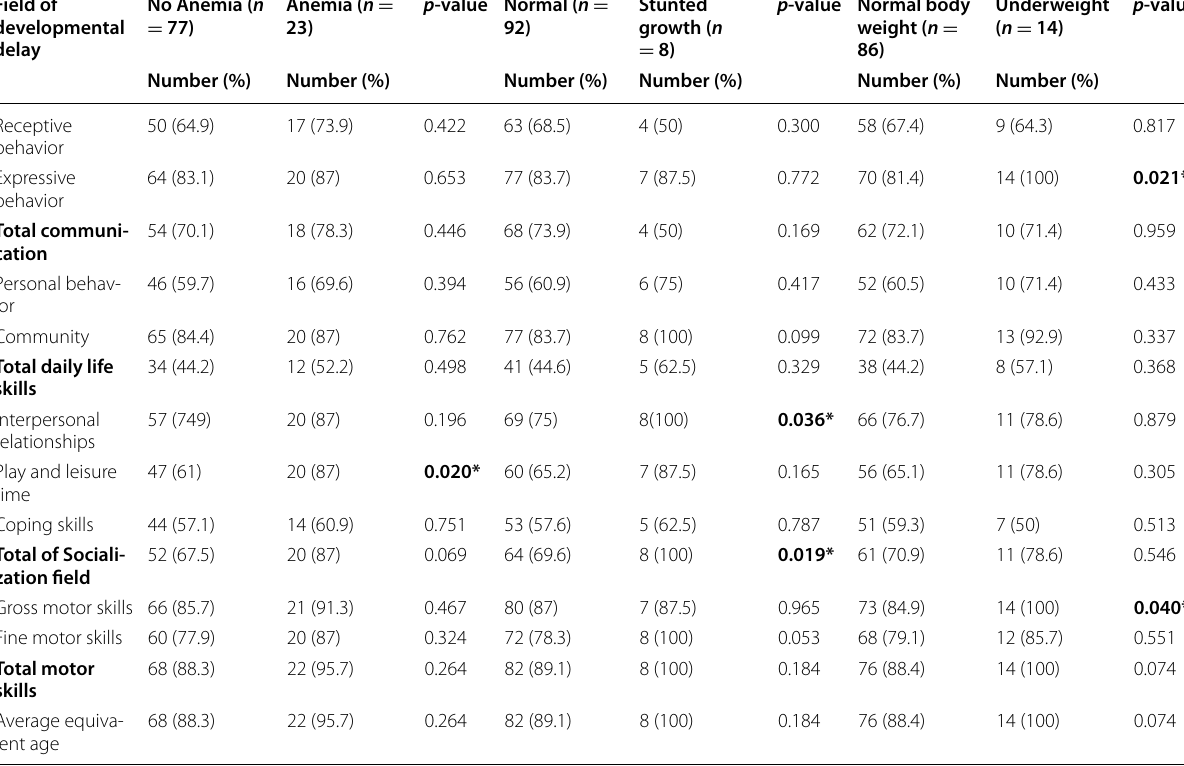
Table 3 Comparison between the presence of anemia, stunted growth, or underweight as regard results of